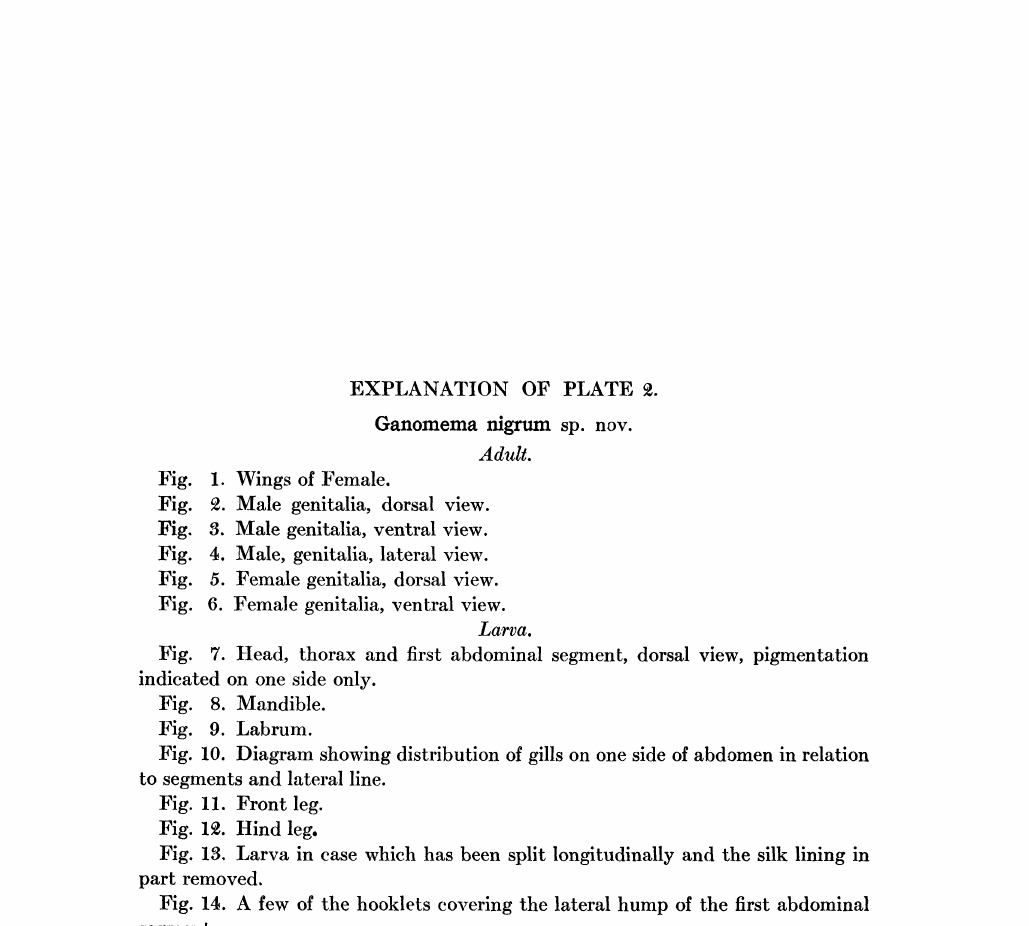
. Adult. Fig. 1. Wings of Female. Male genitalia, dorsal view. Fig. Fig. 3. Male genitalia, ventral view. Fig. 4. Male, genitalia, lateral view. Fig. 5. Female genitalia, dorsal view. Fig. 6. Female genitalia, ventral view. Larva. Fig. 7. Head, thorax and first abdominal segment, dorsal view, pigmentation indicated on one side only. Fig. 8. Mandible. Fig. 9. Labrum. Fig. 10. Diagram showing distribution of gills on one side of abdomen in relation to segments and lateral line. Fig. 11. Front leg. Fig. 1. Hind leg. Fig. 13. Larva in case which has been split longitudinally and the silk lining in part removed. segment. Fig. 15. Frons. Fig. 16. Caudal portion of abdomen, lateral view. Fig. 17. Caudal portion of abdomen, dorsal view. Pupa. Fig. 18. Dorsal plates of the left side numbered according to the segments on which they occur. Fig. 19. Anal appendages, dorsal view. Fig. 0.